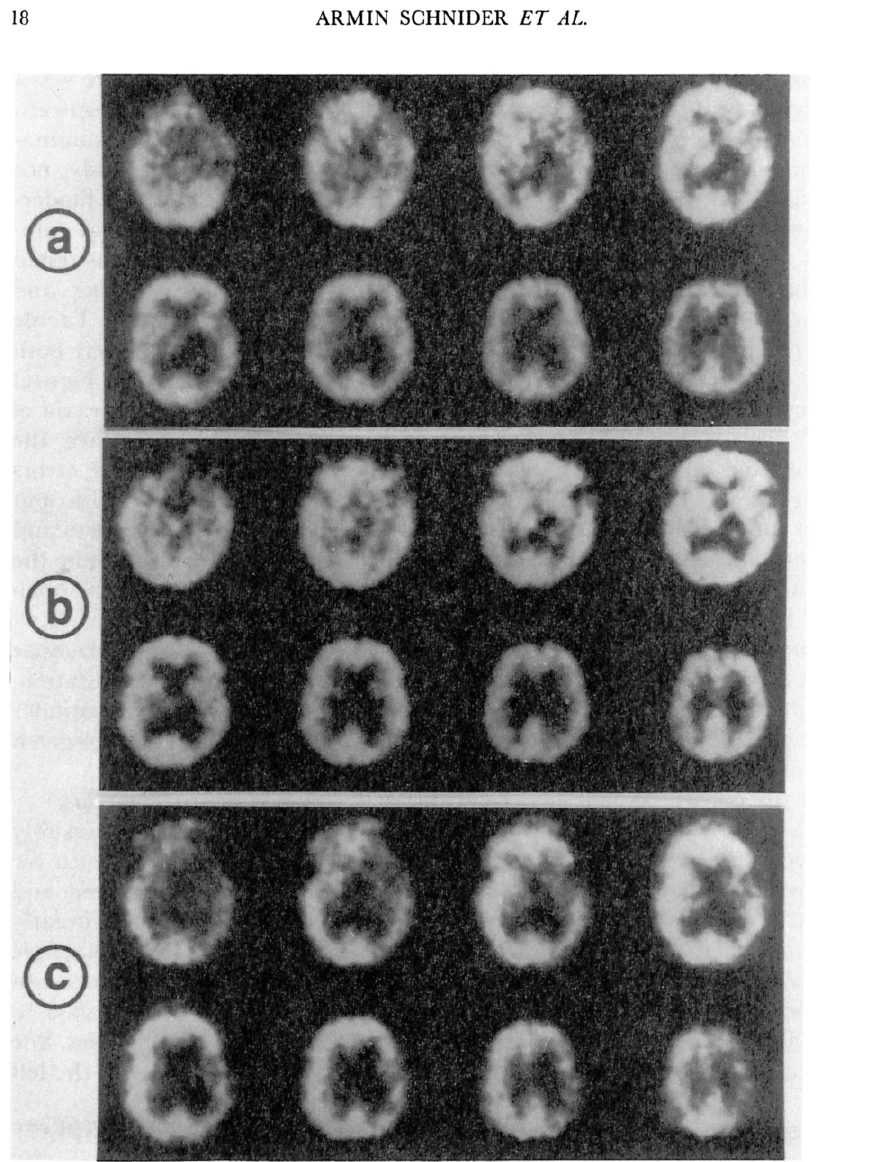
FIG. 2. SPECT studies on (a) day 4, showing a marked perfusion deficit in the area of the left thalamus and posterior part of the basal ganglia, as well as a hypoperfusion of the whole cortical mantle of9% as compared to the right hemisphere, (b) day 19, with increase of the perfusion deficit of the left hemisphere (14%), despite marked clinical improvement, and (e) day 143, with virtually unchanged perfusion in spite of further clinical improvement. The orientation of the SPECT images corresponds to the CT scan in Fig. 1, i.c. the right side of the images corresponds to the left side of the